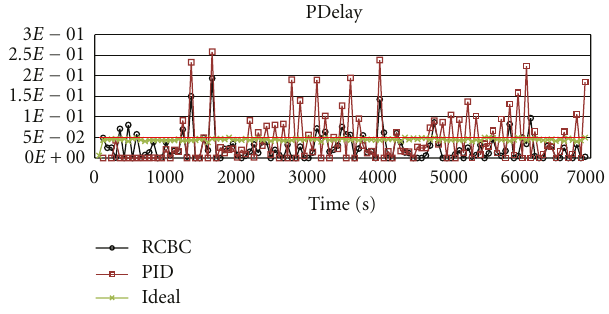
Figure 2: Variable tra ffi c: PDelay (target 5 · 10 − 2 ).